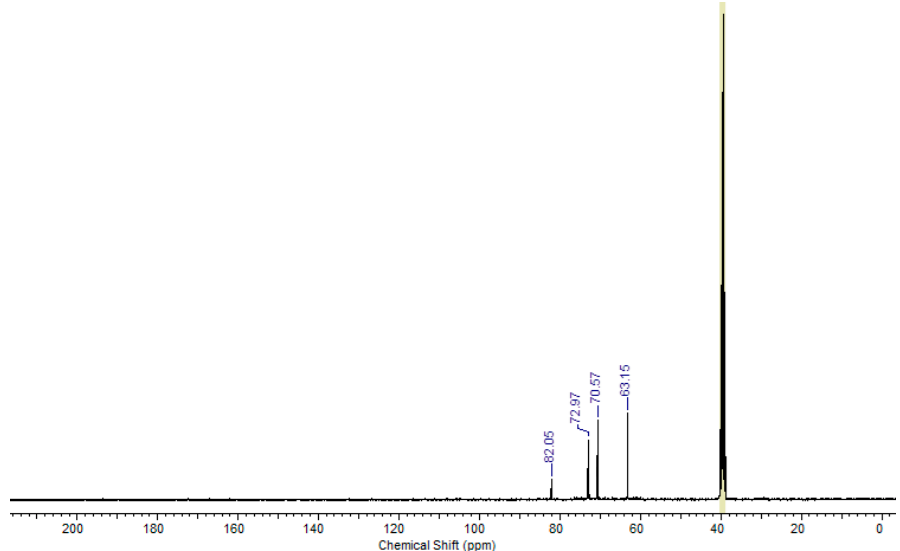
Figure 7. 13 C NMR spectrum of PGL 5/FC—fraction of PGL5/17/T12C16 with double –OH. (100 MHz, DMSO-d 6 ).